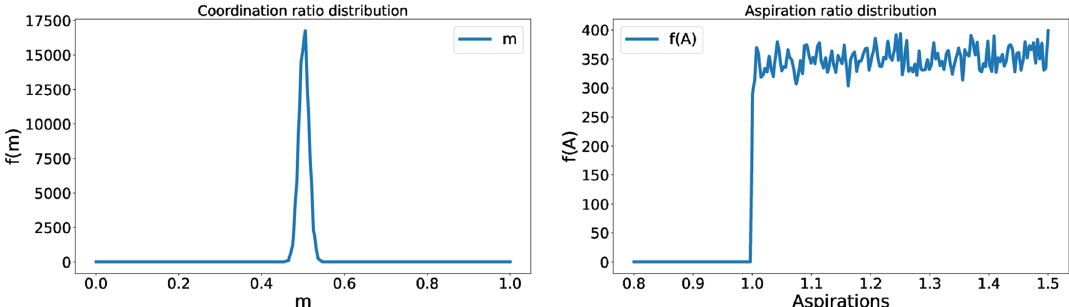
Figure 12. Coordination ratio (left) and aspiration (right) distributions. A 0 = 0.8 and h = 0.5 .